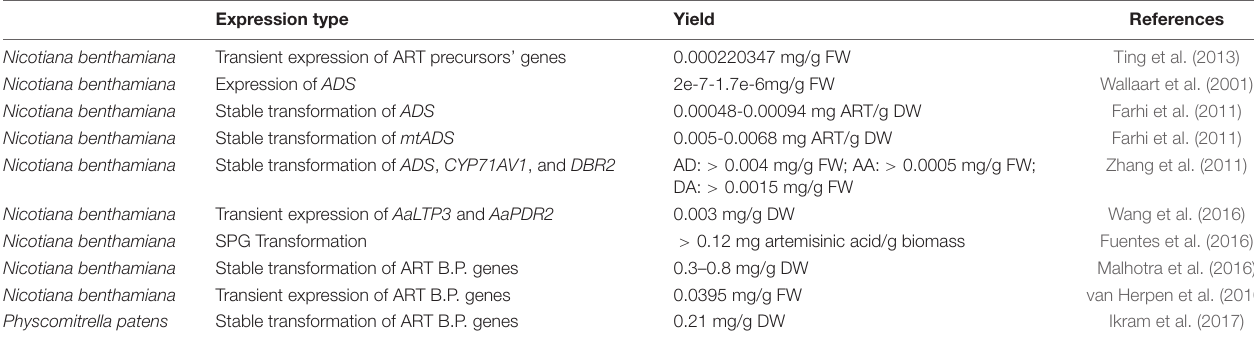
TABLE 3 | Introducing artemisinin (ART) pathway genes in planta to improve the ART production using different strategies. Expression type